Question: Condense the content of this figure into a single sentence.
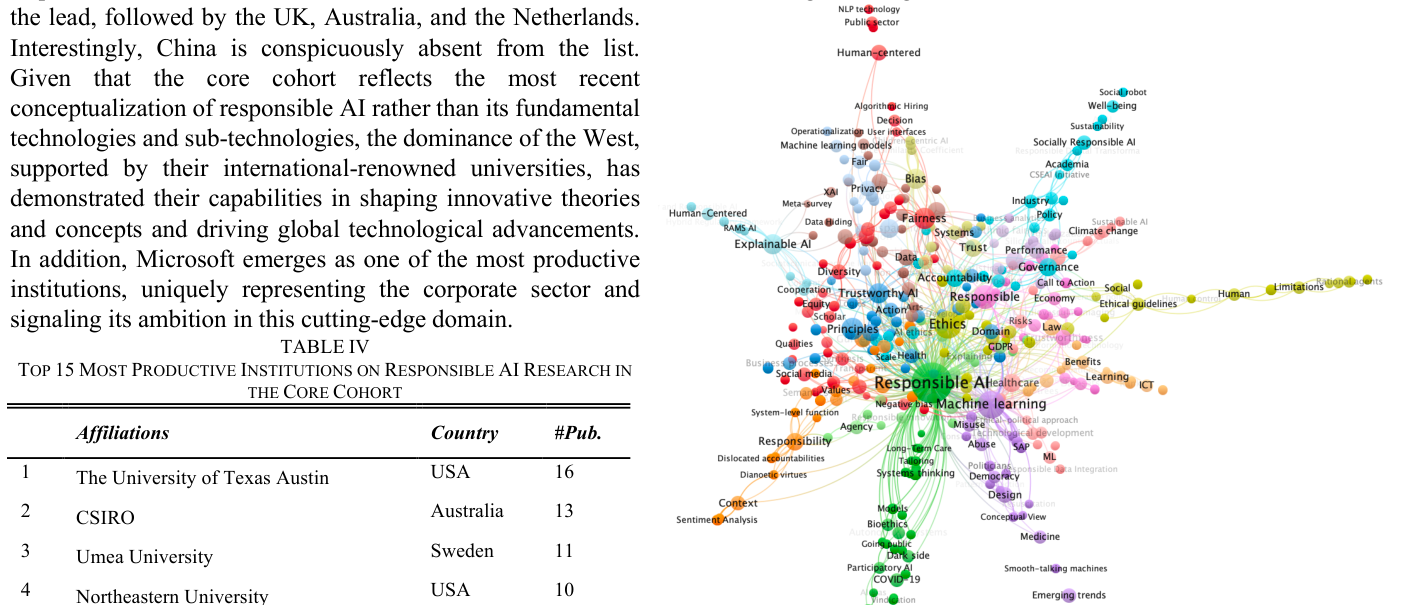
Answer: Co-term Network of Responsible AI Research in the Core Cohort.  Notes. A node represents a term and the edge between two  nodes indicates their co-occurrence relationships. The size of a  node corresponds to the frequency of its related term, while its  color refers to potential semantic similarities measured by the  strength of co-occurrence.